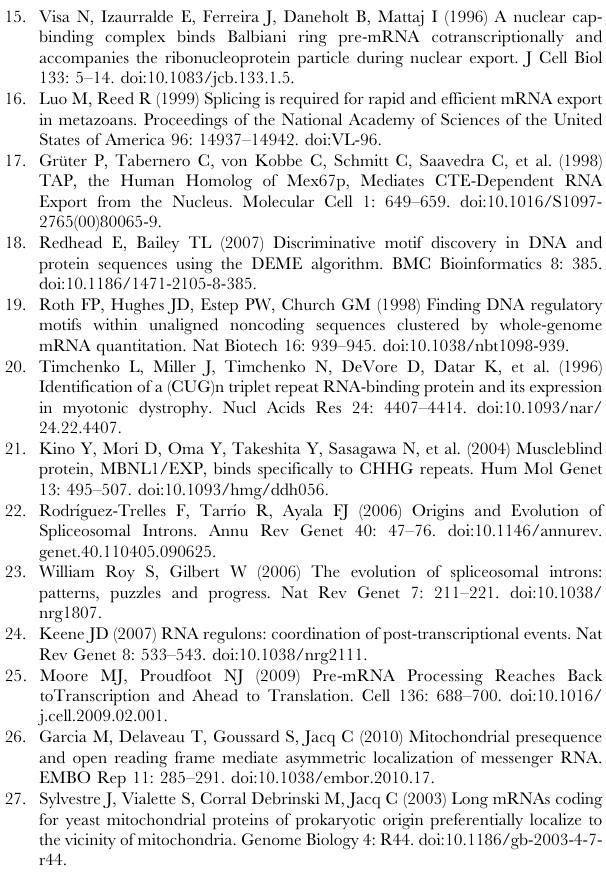
for multiple hypothesis testing was done using a resampling approach (see [35] for details). Table S2 19 motifs discovered by AlignACE are significantly represented among 5UI 2 Genes. AlignACE motifs that were enriched among 5UI 2 genes and the DEME motif were shown. There were 938 and 2594 total sequences in the 5UI + set and the 5UI 2 set, respectively. Fisher’s exact test was used to test the significance of enrichment of motif containing genes among 5UI 2 genes. Text S1 The depletion of 5UIs from SSCRs and MSCRs is not attributable to differences in 5 9 UTR